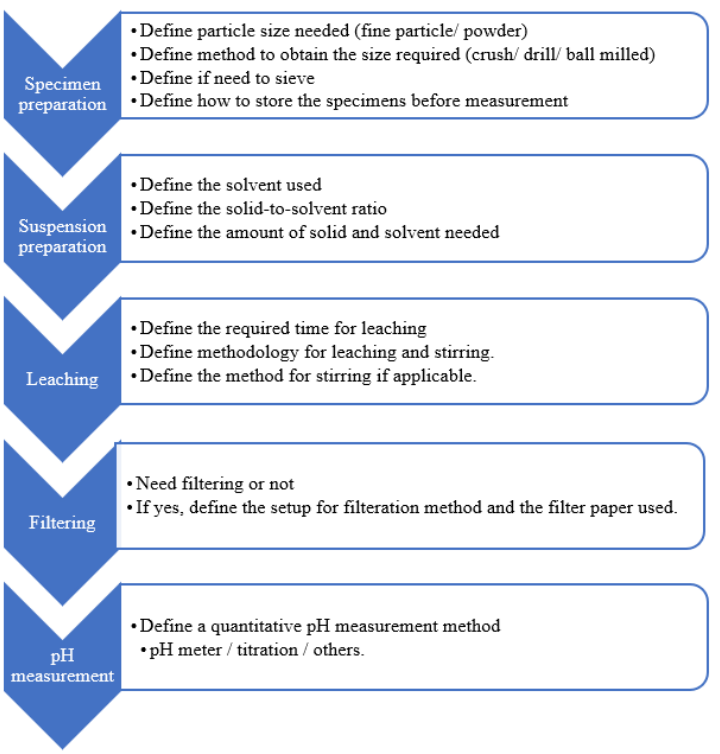
Figure 2. Summary for stages of the ESL method. Table 1. Particle sizes used by different researchers in the ESL method.